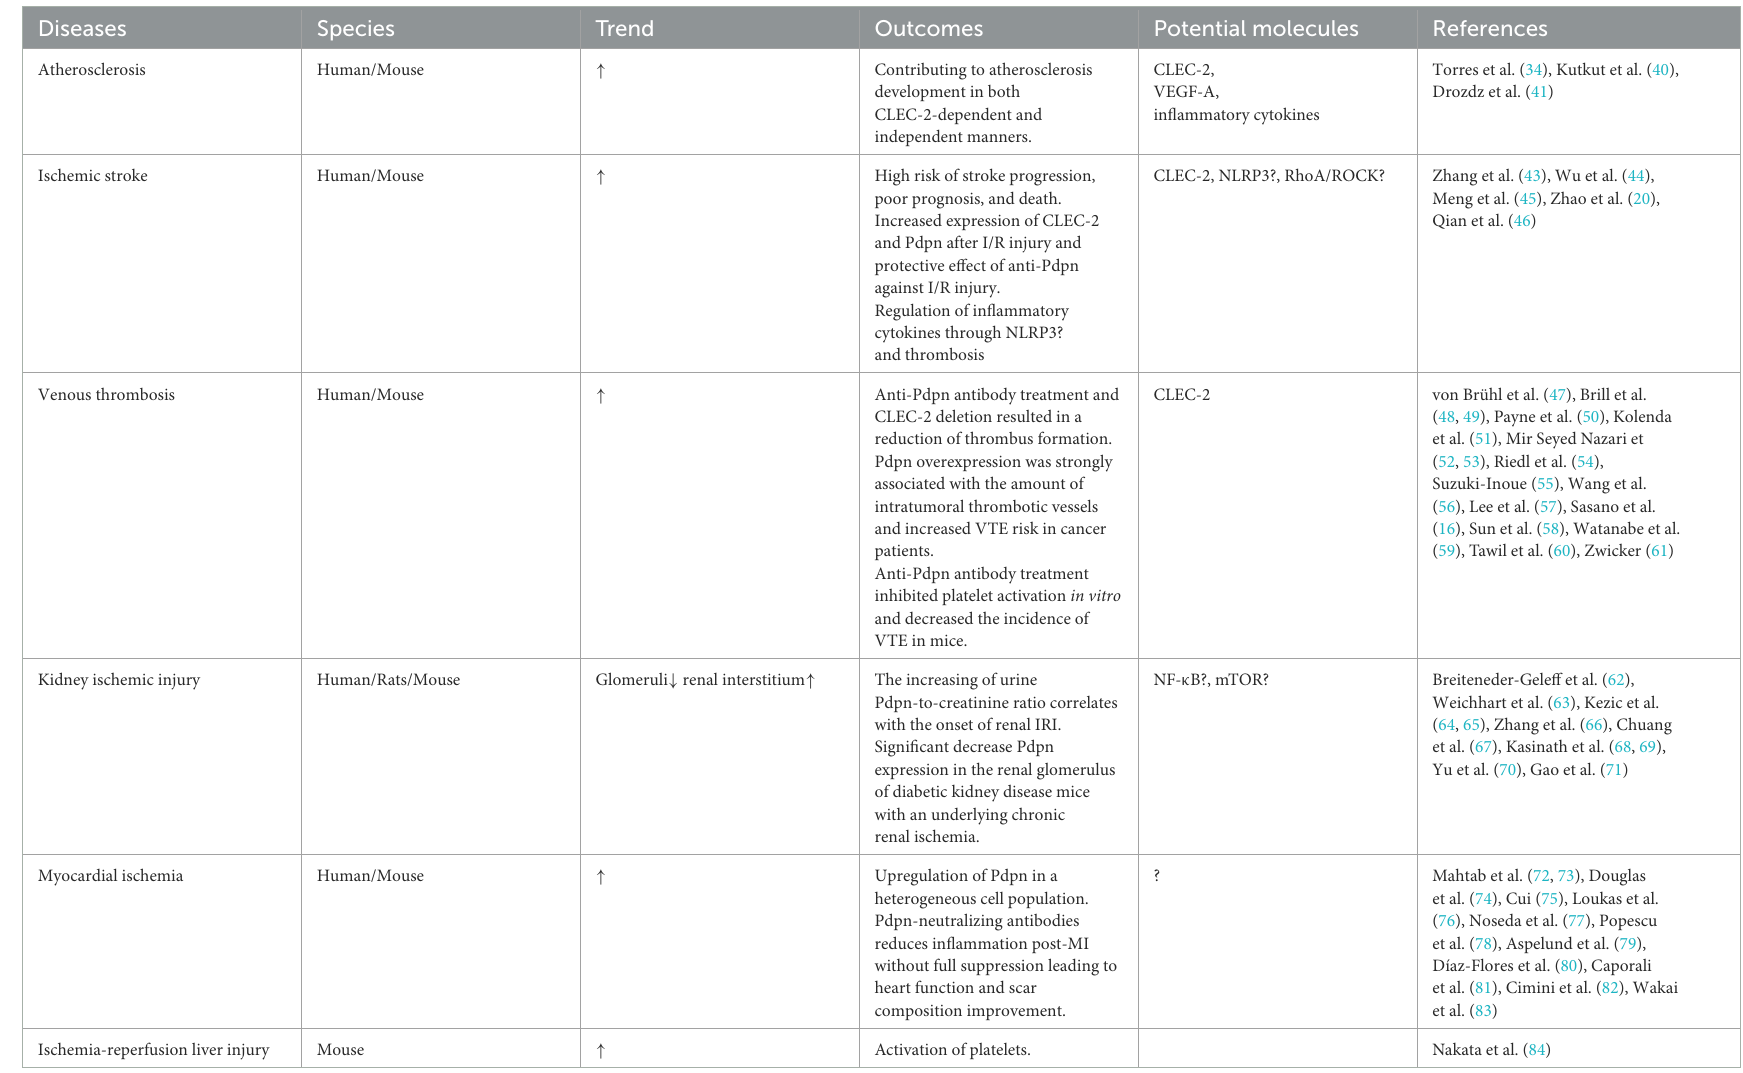
TABLE 1 Pdpn in thrombotic